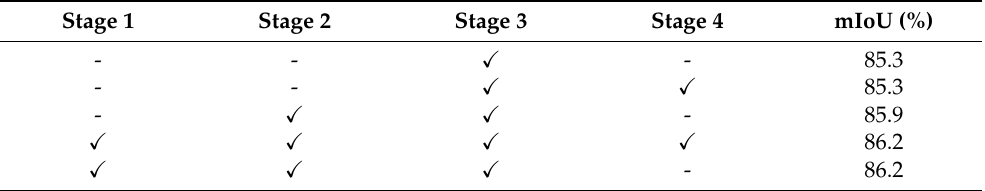
Table 7. Effect of the auxiliary segmentation head at different stages.